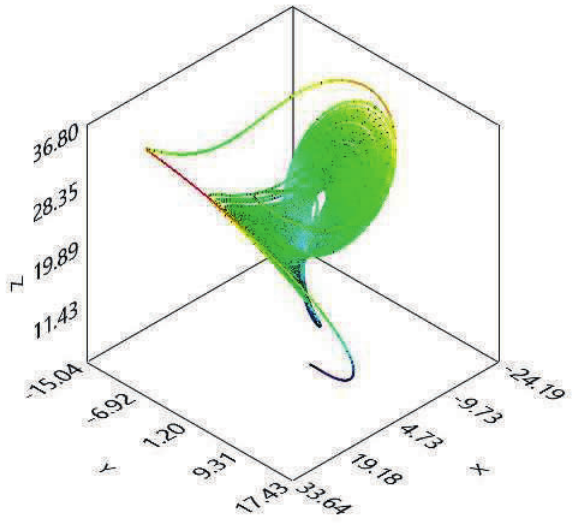
Fig. 2: 3D State portrait of the Fractional order PMSG